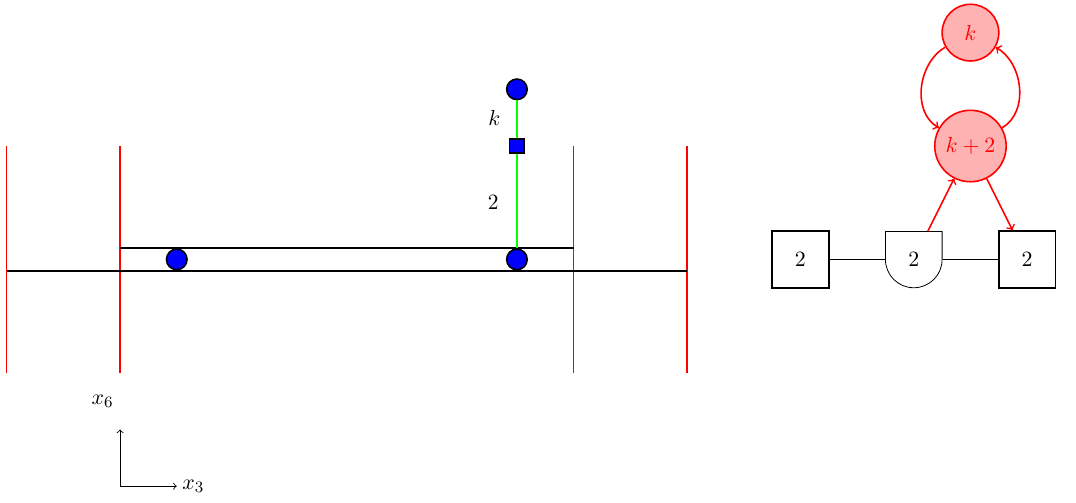
Figure 14 . Type IIB brane construction for the right 3d-1d quiver that realizes a vortex defect V 2 ,R for the U(2) gauge group in the representation R = S k ⊗ A 2 .